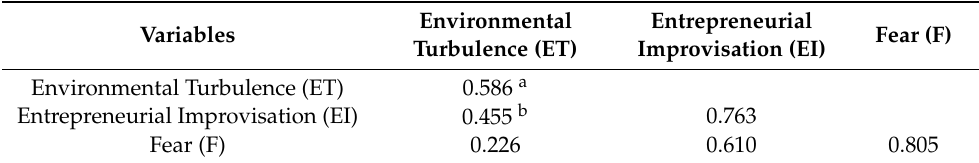
Table 4. Discriminant validity.